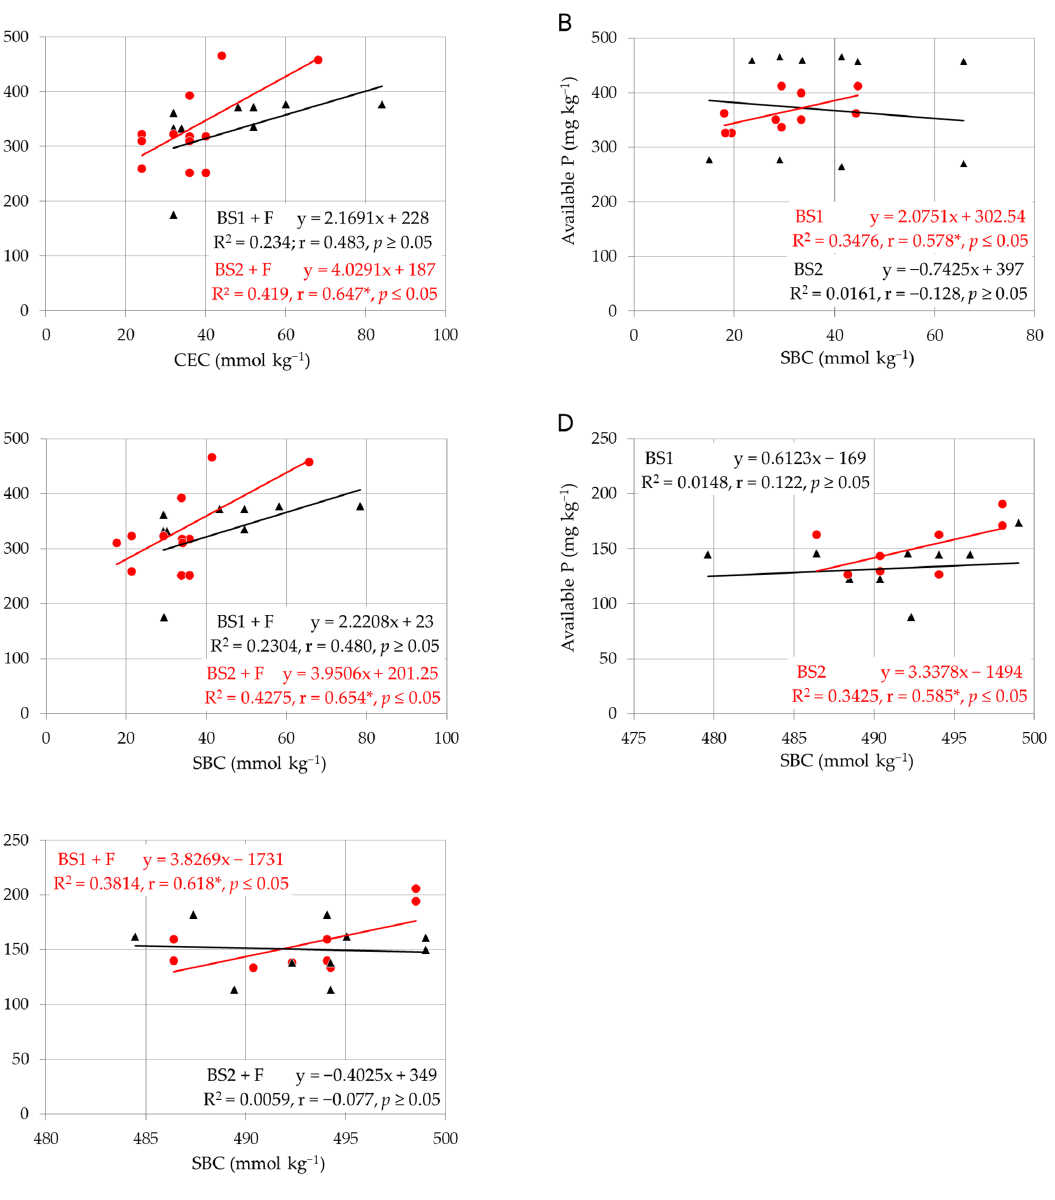
Figure 1. The linear dependence between selected soil properties and P availability for chosen treatments in sandy soil: ( A ) Cation exchange capacity (CEC) in fertilized treatments; ( B ) Sum of basic cations (SBC) in nonfertilized treatments; ( C ) Sum of basic cations (SBC) in fertilized treatments. The linear dependence between sum of basic cations (SBC) and P availability in loamy soil: ( D ) In chosen nonfertilized treatments; ( E ) In chosen fertilized treatments. Red circles and * indicate significant correlation at p ≤ 0.05.